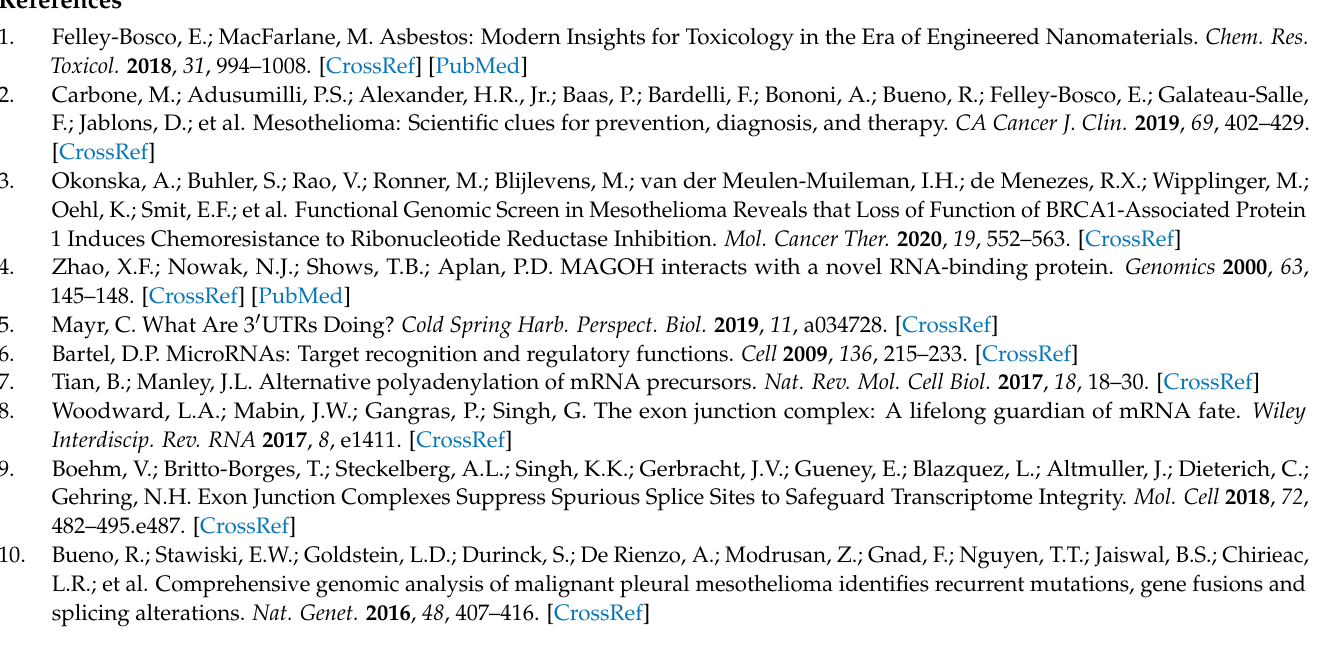
Supplementary Materials: The following are available online at https://www.mdpi.com/article/ 10.3390/cells10123543/s1, Figure S1: Correlation of RBM8A protein and RNA expression in different human cell lines. Figure S2: Rbm8a mRNA expression in crocidolite (blue asbestos)-exposed mice and abundance of RBM8A transcripts in mesothelial cells or various cancers. Figure S3: dsRNA stretch of RBM8A 3 (cid:48) UTR formed by AluY and AluSz6 elements. Figure S4: ADAR1/2 mRNA heterogeneous expression in four MPM cell lines. Figure S5: Editing of RBM8A 3 (cid:48) UTR AluY-AluSz6 entails structural changes. Figure S6: MSI2 expression is higher compared to MSI1 in MPM. Figure S7: AluY-AluSz6 sequence is highly conserved between humans and primates. Figure S8: AluY-AluSz6 dsRNA structure is conserved in other transcripts enriched in the MPM translatome. Table S1: Sequences of primers. Table S2: Percentage of A to G editing in RBM8A AluY element. Table S3: Statistical analysis of AluSz6 editing after ADAR1/2 silencing in Mero-82, Mero-95, NCI-H226, and SPC111 MPM cells. Table S4: Prediction of miR targeting in unedited vs. edited Alu Sz6 sequence. Table S5: Transcripts containing inverted AluY and